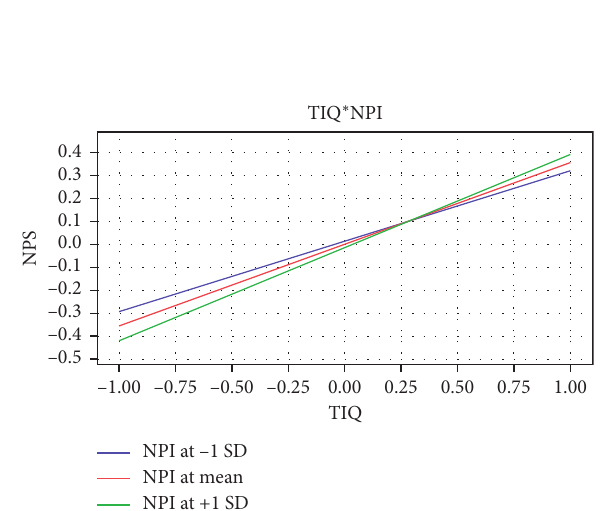
Figure 9: TIQ ∗ NPI.